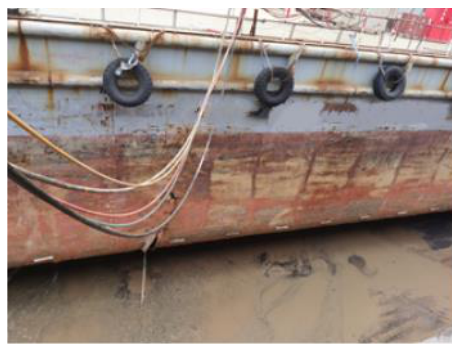
Figure 4. Torn and damage of starboard shell.